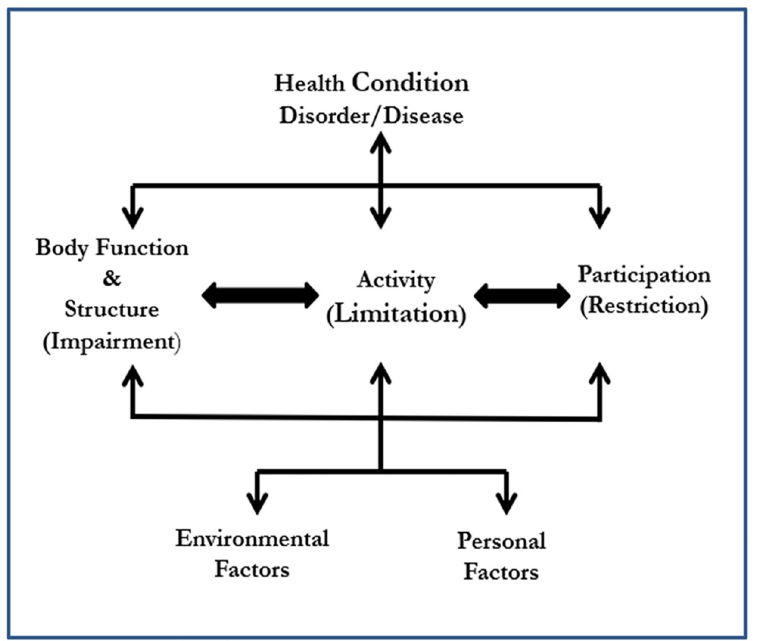
Fig 2. The ICF model for measuring health and disability (Source: